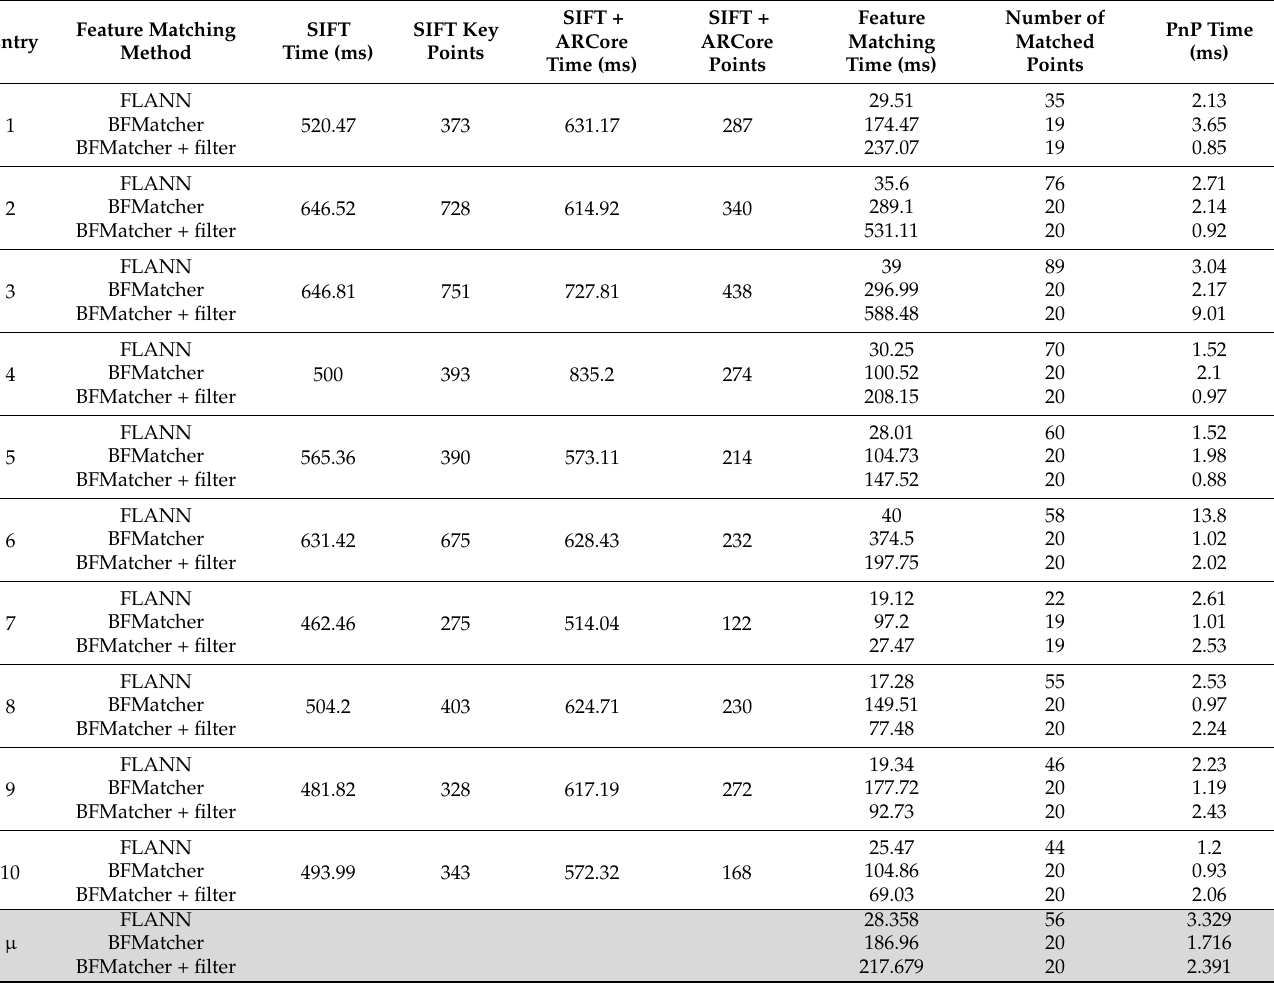
Table 3. The computing times of the feature matching algorithms, of the SIFT detector, of the selection of SIFT plus ARCore feature points and of the PnP algorithm. The number of SIFT key-points, the number of SIFT plus ARCore points and the final number of matched feature points used in the PnP algorithm, are also